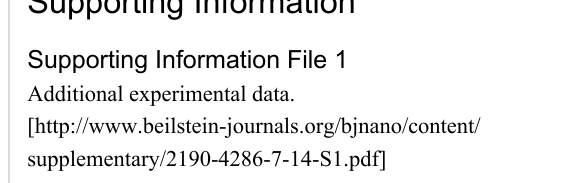
The particles were washed and dried under the same circum- stances so that a coloring influence of different solvent molecules can be foreclosed. Thus the visual input of the MNP can give a first cautious estimation of a successful func-